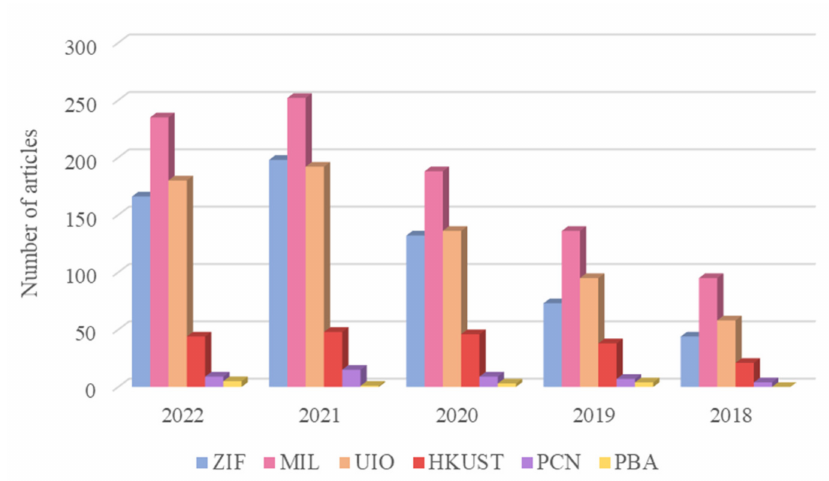
Figure 2. Evolution of the number of published articles on wastewater treatment for each type of MOF in the last five years.